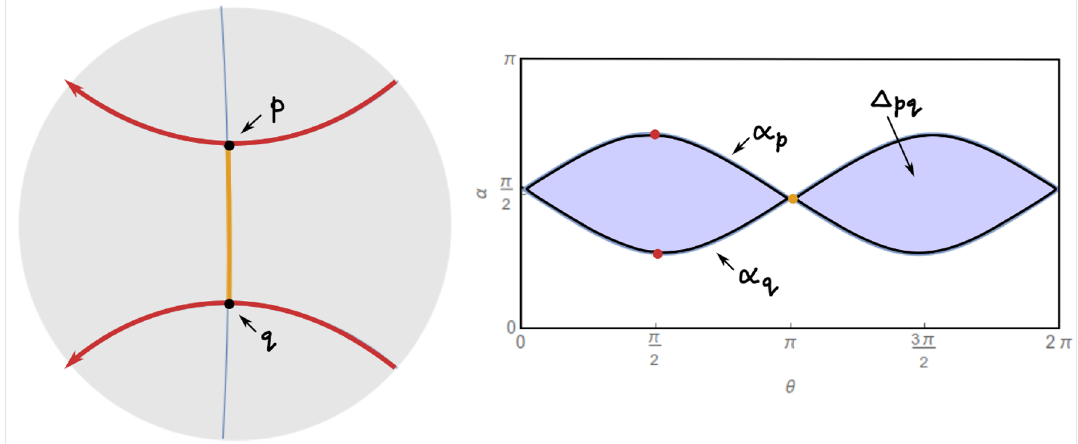
Figure 12. Left: a BTZ black hole generated in global AdS 3 through identification the two red geodesics. The event horizon is drawn in orange. Right: K of global AdS are point curves α ( θ ) , α ( θ ) and they enclose the region ∆ p q the event